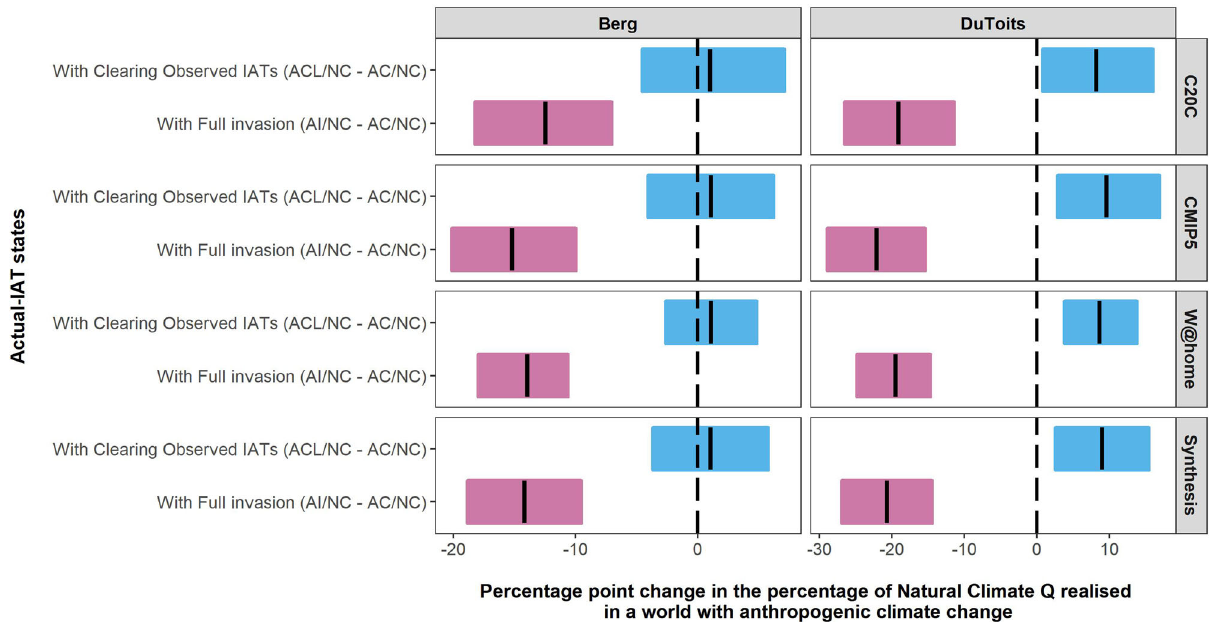
Fig. 5 The impact of IAT clearing (and lack thereof) on ameliorating or exacerbating the reduction in 2015 – 2017 drought-period stream fl ow from anthropogenic climate change. For each catchment (Berg and Du Toits, South Africa), and for fully cleared or fully invaded IAT states, the difference in QR % relative to that for current IAT conditions are shown (QR% point difference) (also see Supplementary Table 2). Changes are shown for each climate model experiment (C20C, CMIP5 and W@home) and for the multi-model experiment synthesis (Synthesis). The solid line is the median change, while the coloured bar shows the 95% con fi dence interval (Methods and Supplementary Methods 1). NC Natural Current, AC Actual Current, ACL Actual Cleared, AI Actual